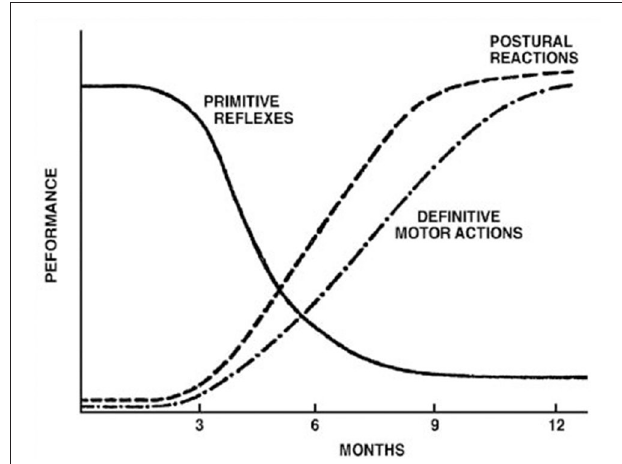
FIGURE 1 | Development of postural reflexes. The diminishing of primitive reflexes and the growing importance of postural reactions indicate the development of requisite conditions for the development of the purposeful movement. The collective time course of primitive reflexes under normal circumstances is compared with the time course of the maintenance of static deep tendon reflexes and postural reactions. Reproduced with